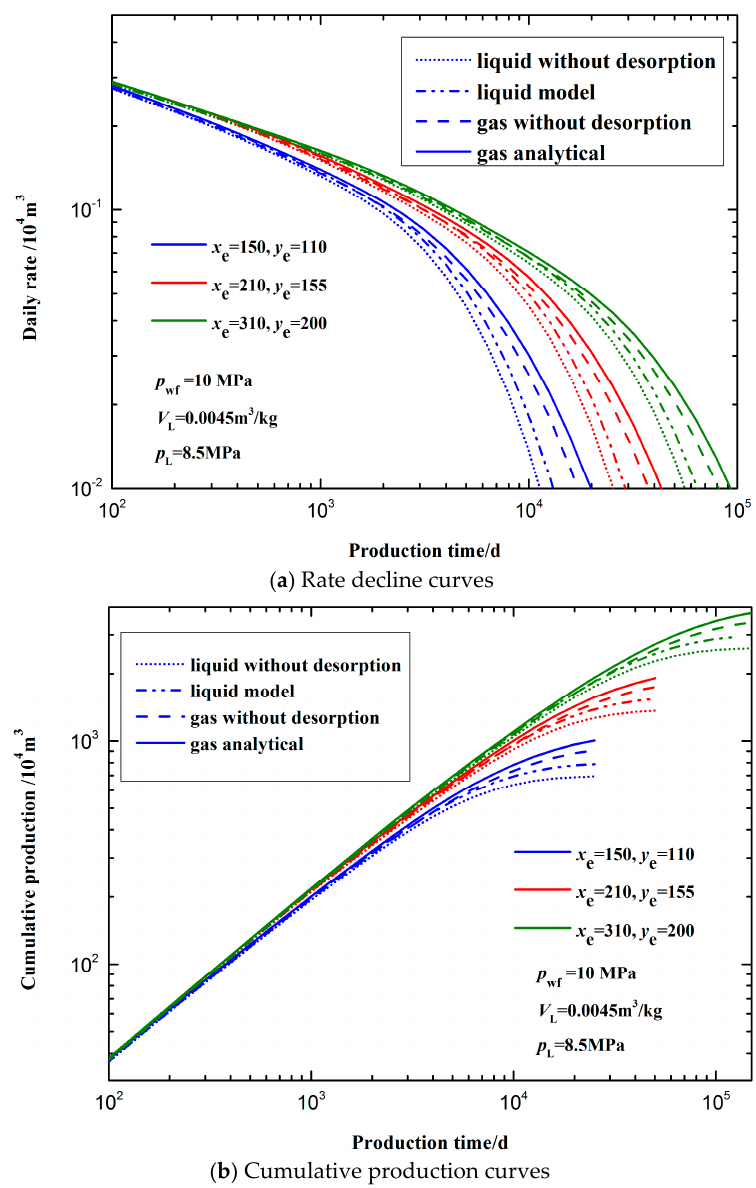
Figure 7. Effects of depletion-driven fluid properties, gas desorption, and outer boundary on production behavior.